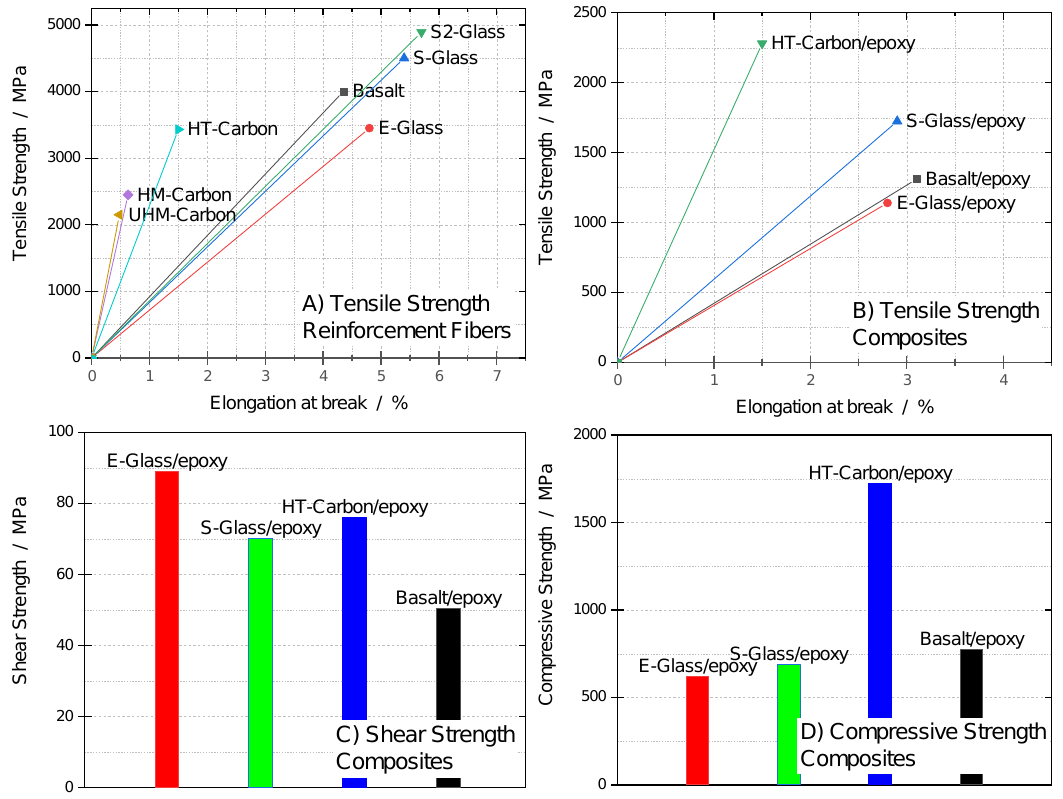
Figure 7. Typical mechanical properties of basalt, carbon and glass fibers and their unidirectional (UD) epoxy composites. Basalt/epoxy results stem from the present study, other fiber and composite properties are taken from Reference [28–31]. ( A ) Tensile strength of common reinforcement fibers, ( B ) Tensile strength of different fiber/epoxy composites (UD, tensile loading in 0 ◦ direction). ( C ) Shear strength and ( D ) Compressive strength of fiber/epoxy